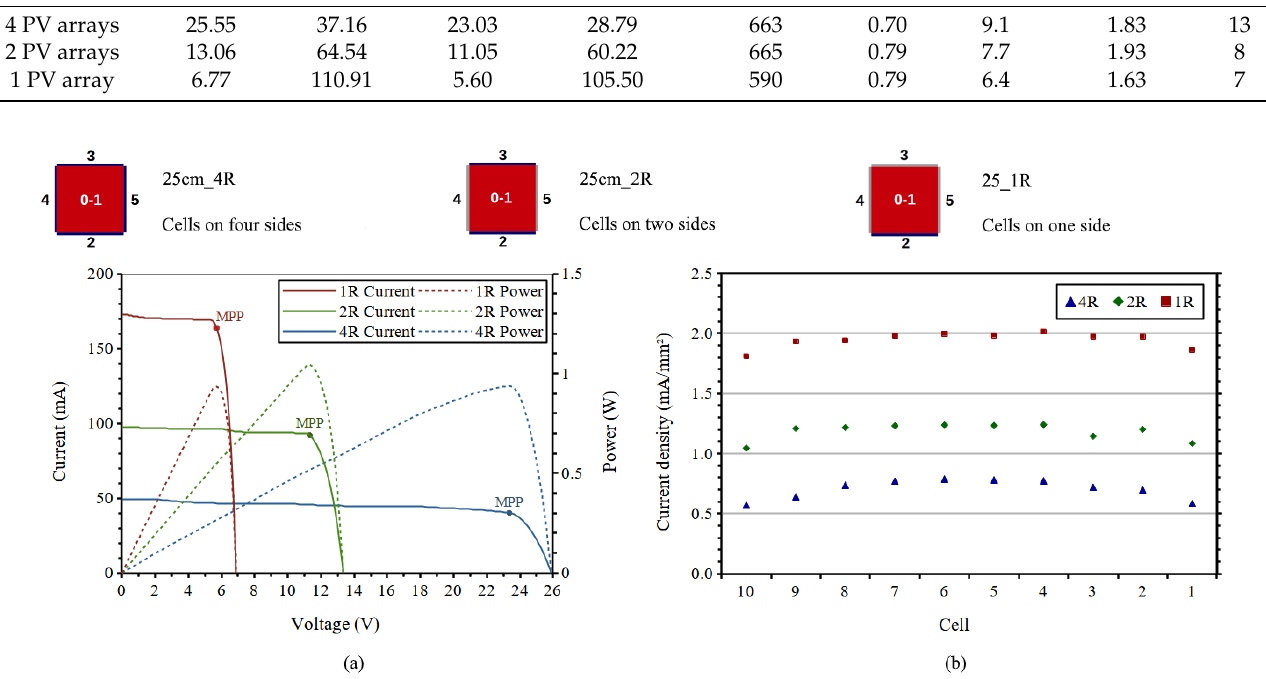
Figure 21. ( a ) Characteristic curve (I-V and P-V) of the unshaded LSC panel with one (red), two (green) and four (blue) 10-cells PV arrays under a GNI of 1000 W/m 2 . ( b ) Current density produced by each configuration: one (red squares), two (green diamonds) and four receivers (blue triangles).